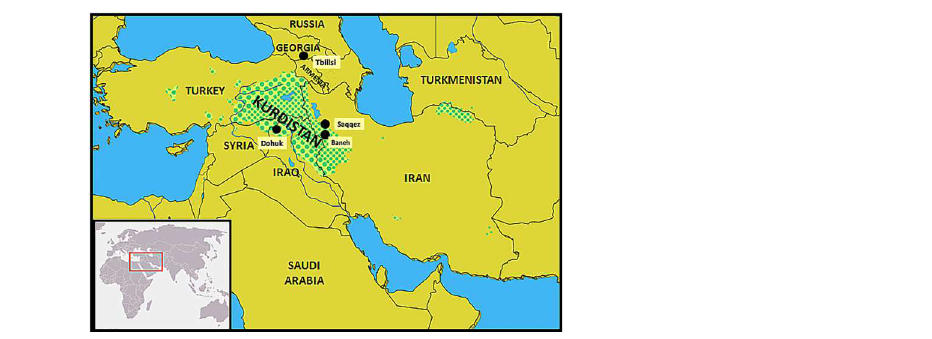
Fig 1. Geographical location of Duhok in the Kurd Autonomous Province of Iraq. Erbil is province capitaland is locatedabout 170 km South East Duhok. (This Fig is similar but not identicalto Fig 1 in Ref [13]; It has been includedonly for illustrative purposes).